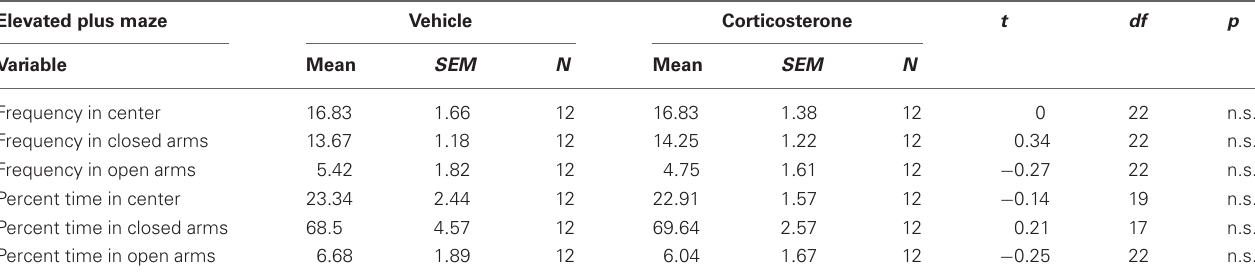
Table 1 | Effect of corticosterone or vehicle administration during peripuberty on anxiety-like behaviors as assessed in the elevated plus maze in